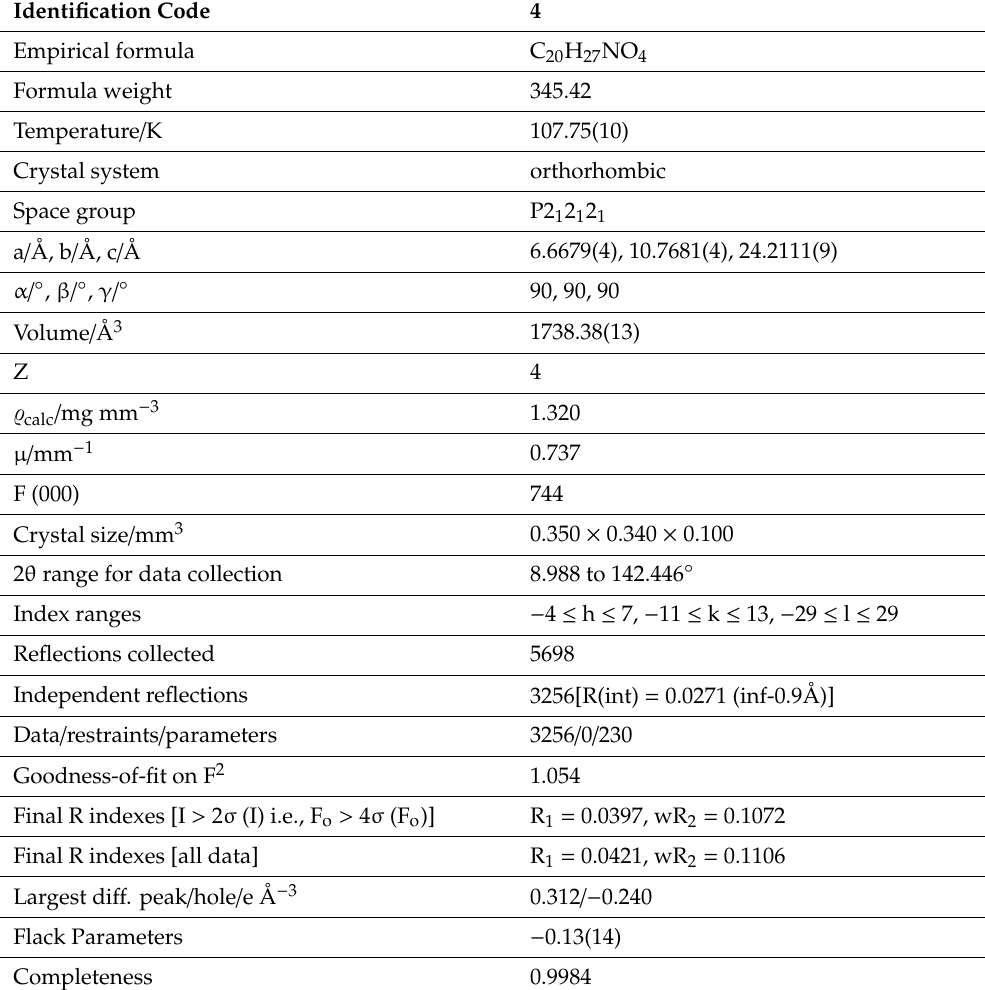
Table 3. Crystal data and structure refinement for compound 4